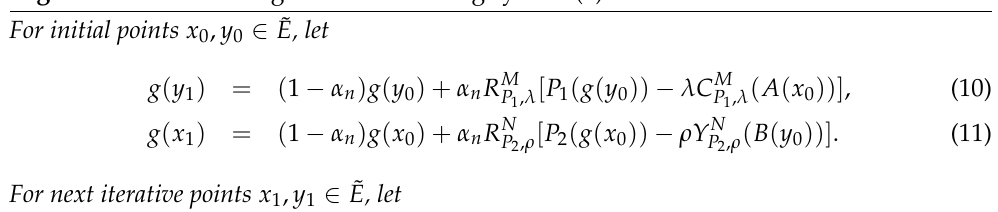
Algorithm 1 Iterative algorithm for solving system